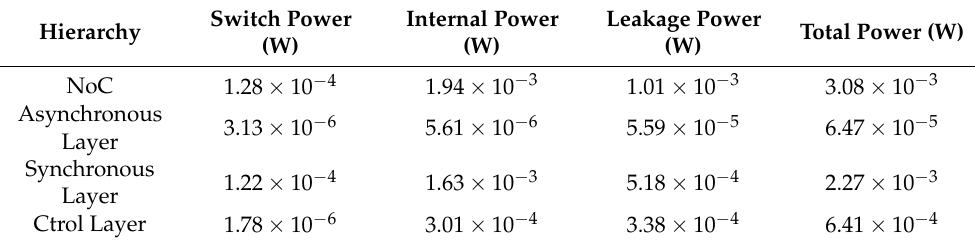
Figure 17. The power comparison showing the overall reduction for the proposed double-layer NoC. Table 2. Hierarchical power analysis for the proposed double-layer NoC.